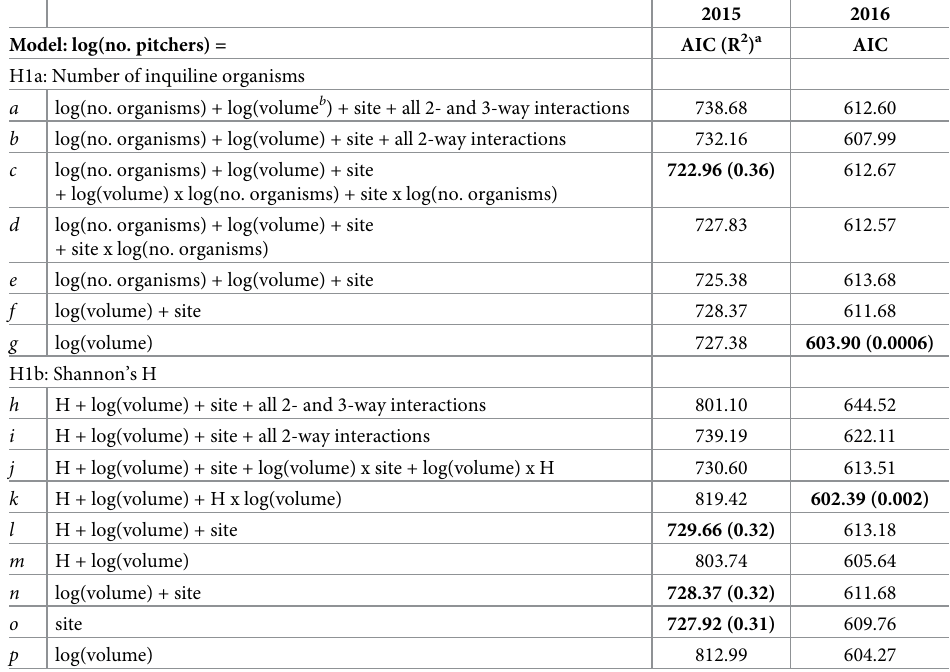
Table 3. Comparison of model fit examining H1 that inquiline abundance and diversity affect vegetative